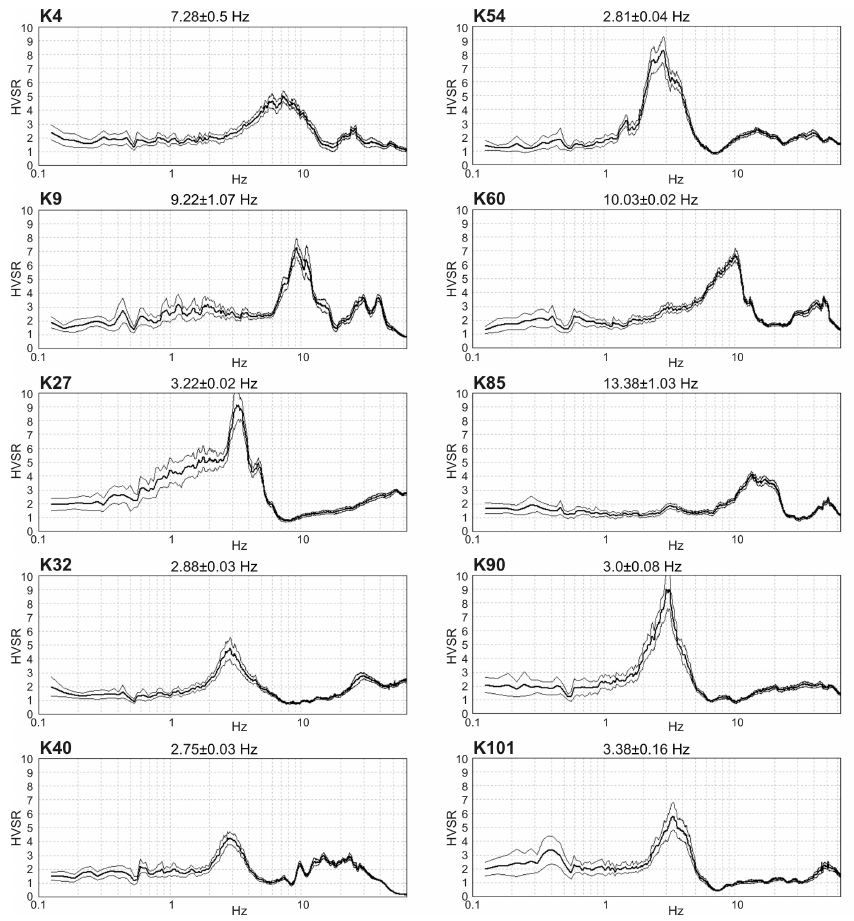
Fig. 3. Some examples of microtremor measurements (HVSR analyses) with clear peaks. Locations of measurements are shown in Fig. 2. Thin lines represent the 95% confidence